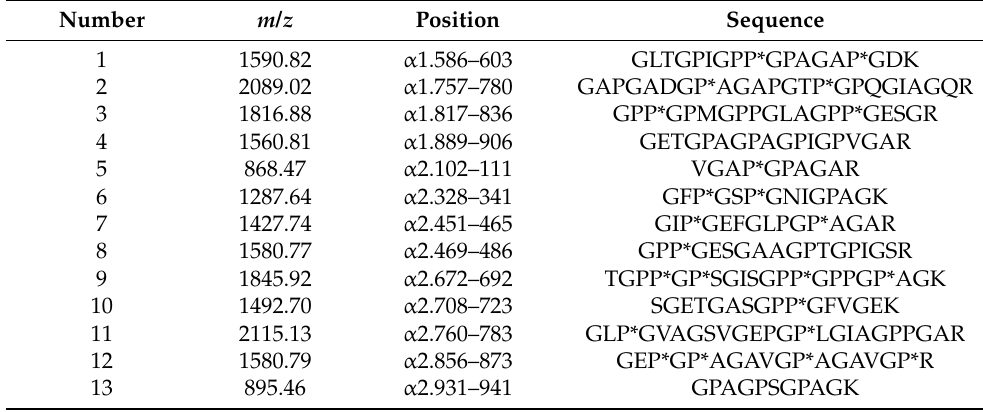
Figure 5. Total ion chromatograms of the bovine gelatins digested at 37 °C for 12 h. ( A ) Bovine gelatin; ( B ) separated gelatin before sample 1 was digested; ( C ) sample 1; ( D ) sample 2. Table 1. Peptides in samples 1 and 2 identified from database searching.